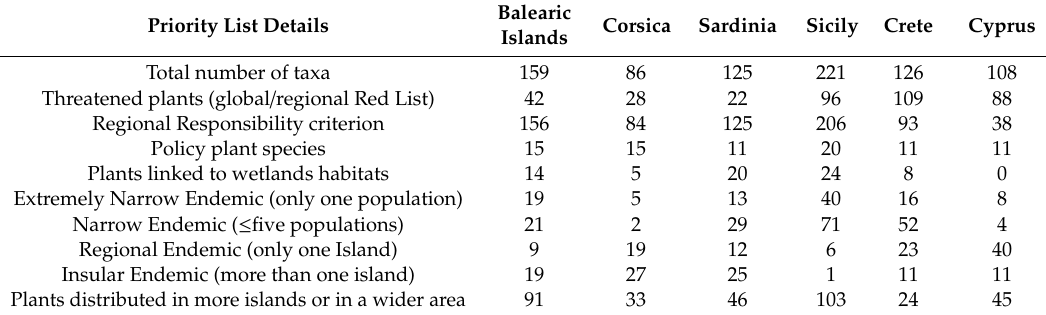
Table 1. Detailed report of the priority list of the selected plants at the island level. One plant could have been selected on the basis of one or more